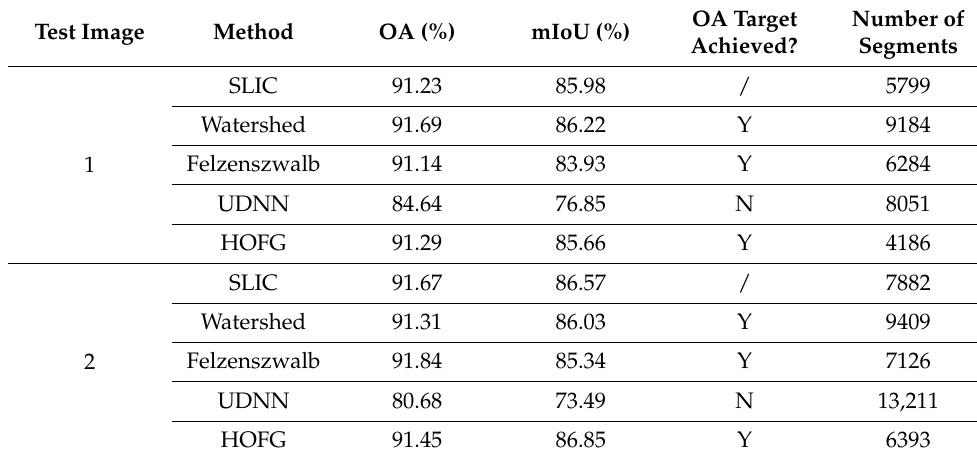
Table 4. Quality evaluation on two test